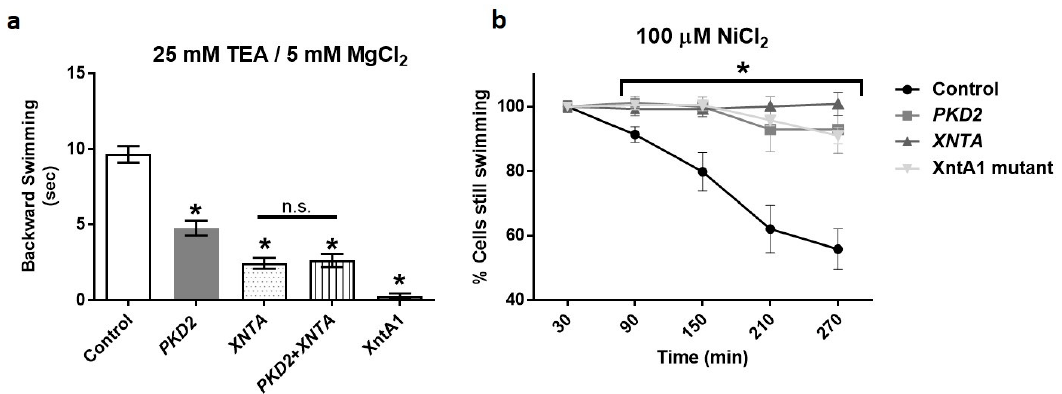
Figure 1. Depletion of PKD2 shows a similar phenotype to XNTA depleted cells. ( a ) Average backward swimming times (sec) ± SEM of wild type (WT) cells fed the empty RNAi vector (Control), WT cells depleted of PKD2 , XNTA , PKD2 and XNTA (PKD2 + XNTA ), or XntA1 mutants in 25 mM TEA with 5 mM MgCl 2 . Cells depleted in PKD2 show significantly shorter backward swimming compared to the controls (* = p < 0.01; T-test); cells depleted in XNTA or PKD2 + XNTA show significantly shorter backward swimming compared to the controls or PKD2 depleted cells (* = p < 0.01; T-tests) and are not significantly di ff erent from one another (n.s.). XntA1 mutants show significantly less backward swimming compared to all other cell types (* = at least p < 0.01; One-way ANOVA, multiple comparison tests). Experiments were repeated at least three times, N = 41–77 cells. ( b ) Heavy metal paralysis test of WT cells fed the empty RNAi vector (control), PKD2 or XNTA depleted WT cells, or XntA1 mutants in 100 µ M NiCl 2 . A minimum of 30 cells, 10 cells per well, were counted in each experiment (N = 12 to 21 wells, experiments repeated at least 4 times). Data are average percent of cells swimming ± SEM at di ff erent time points. Asterisk with bar indicates significantly di ff erent compared to control cells at and post 90 min (* = p < 0.001, ANOVA and multiple comparison tests).